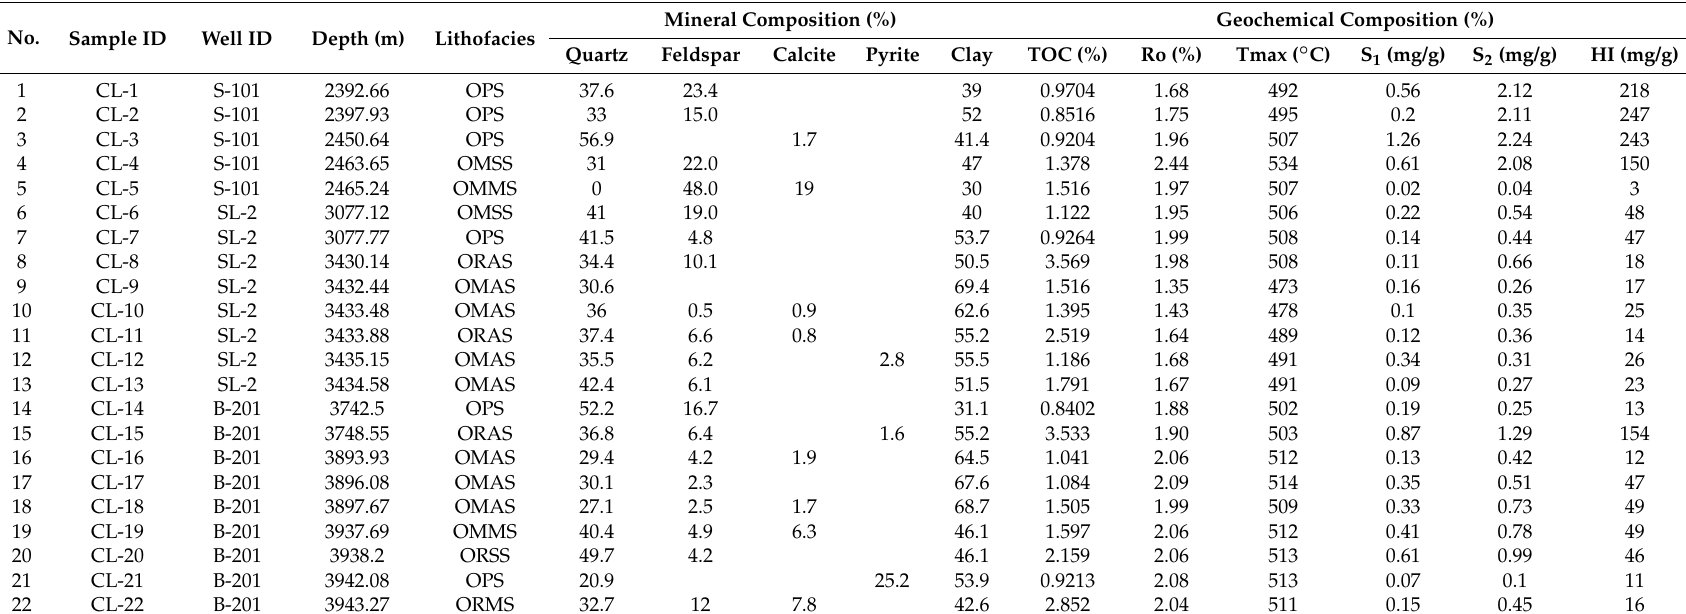
Table 1. Mineral and geochemical compositions of the Shahezi shale in